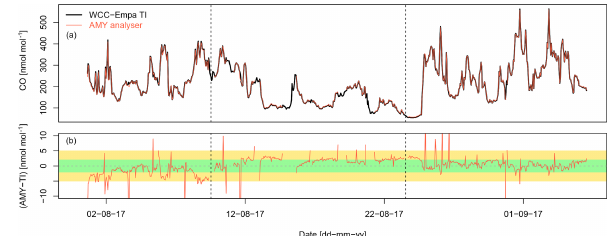
Figure 13. Comparison of hourly averages of CO at AMY between the WCC-Empa travelling instrument and the AMY Los Gatos 30-EP QCL analyser. Both instruments sampled dry ambient air. (a) CO time series. (b) CO bias of the station analyser vs. time. The green and yellow areas correspond to the WMO network compati- bility and extended network compatibility goals. The dashed verti- cal lines indicate the time of the calibration of the AMY instrument.